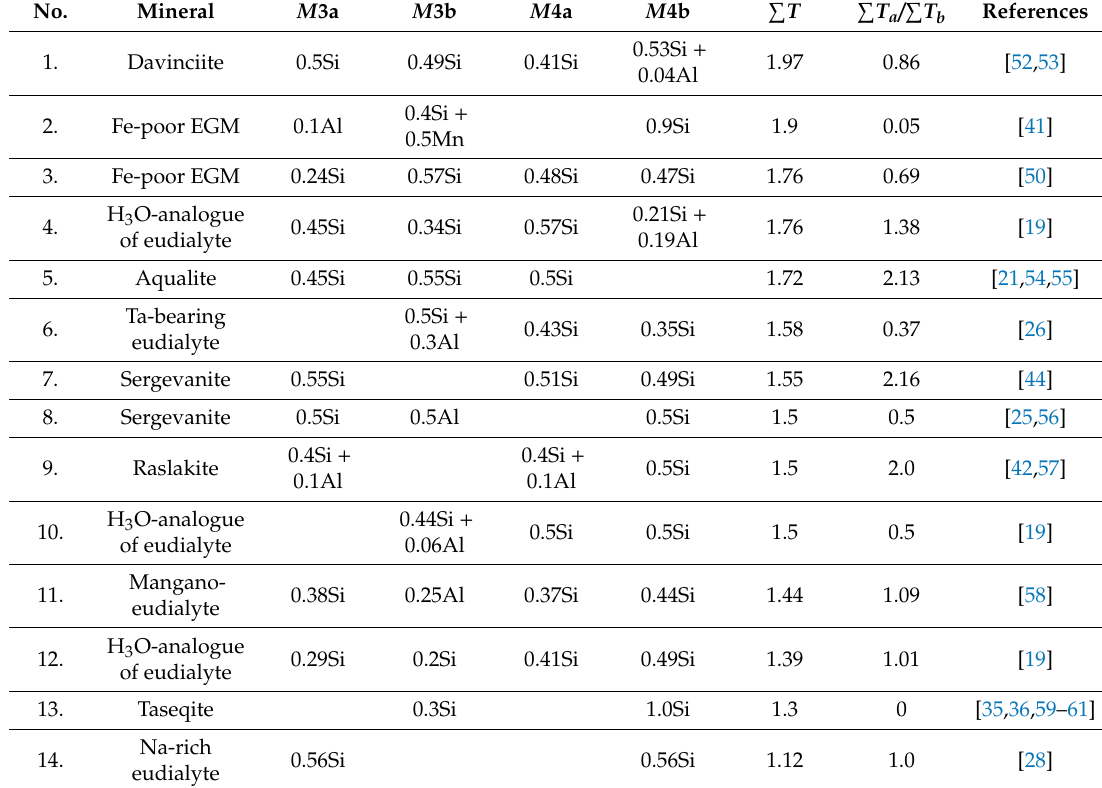
Table 2. Population of tetrahedral sites in the M 3 and M 4 micro-regions, total amounts of the IV M 3 and IV M 4 components ( (cid:80) T , Z = 3) and atomic ratios of the contents of ( IV M 3a, IV M 4a) and ( IV M 3b, IV M 4b) (cid:80) (cid:80) T a / T b ) . The samples are listed in the order of lowering of the cations (